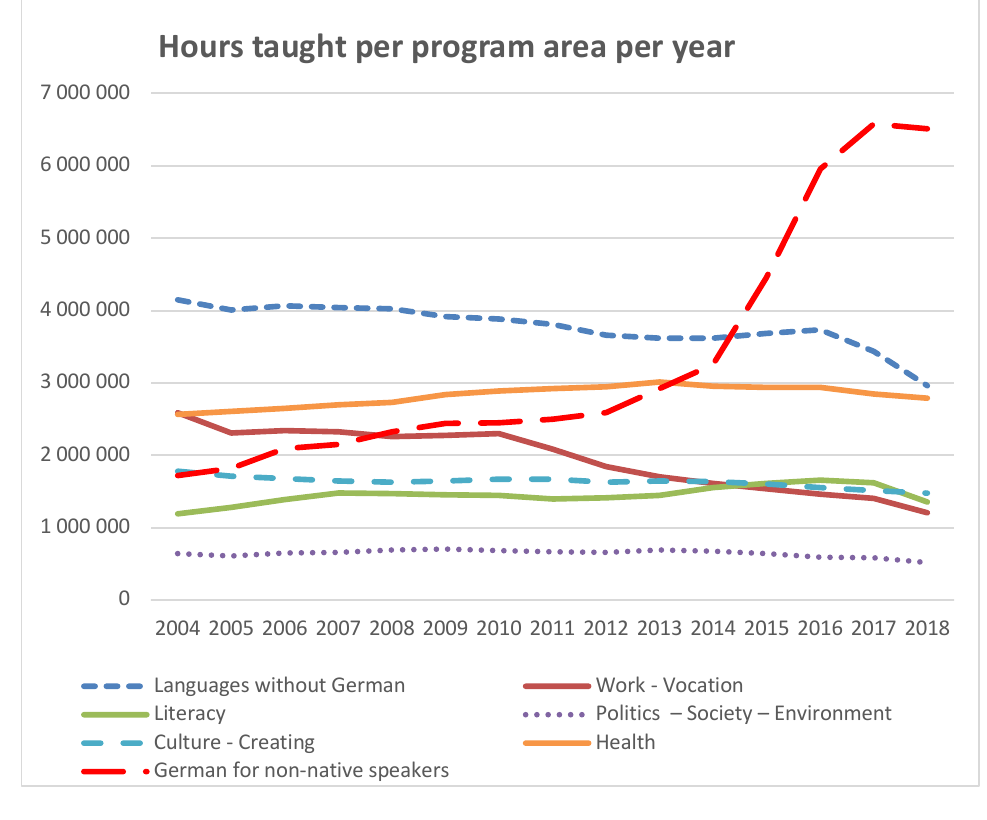
Figure 2. Hours taught per program area per year. (Source: dvv-Statistik. I processed the data by using data from each year that the statistics were